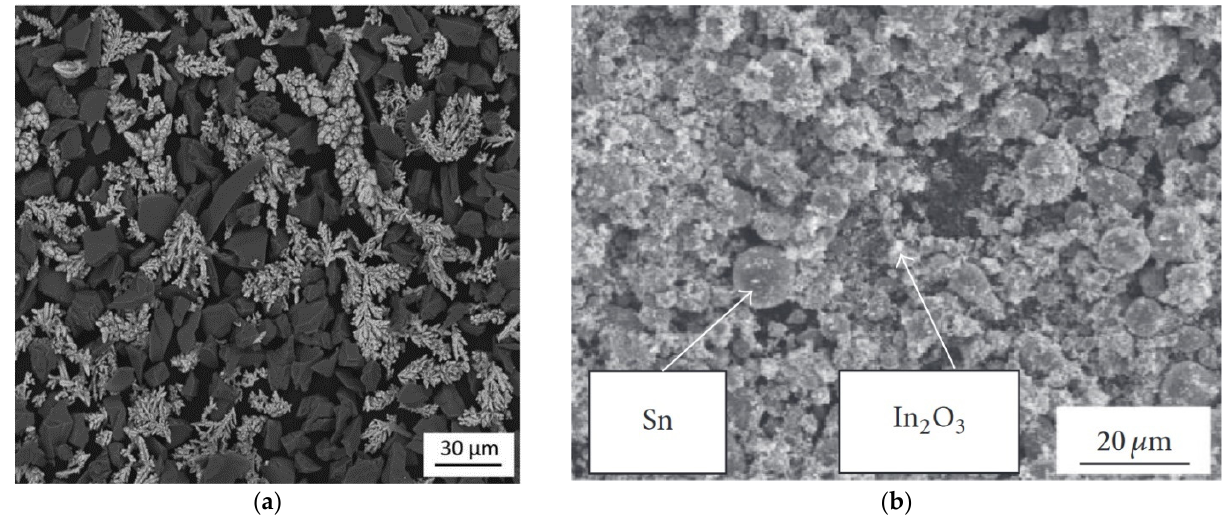
Figure 6. Mechanically blended Cu+Al 2 O 3 powder ( a ) (Reprinted with permission from [82]. Copyright 2017 Springer Nature) and satellited Sn+In 2 O 3 powder ( b ) [117].